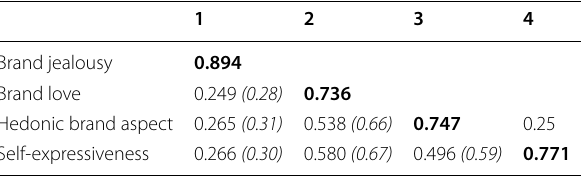
The off-diagonal values are the correlations between latent variables, the diagonal are the square root of AVE, and HTMT values are in italics